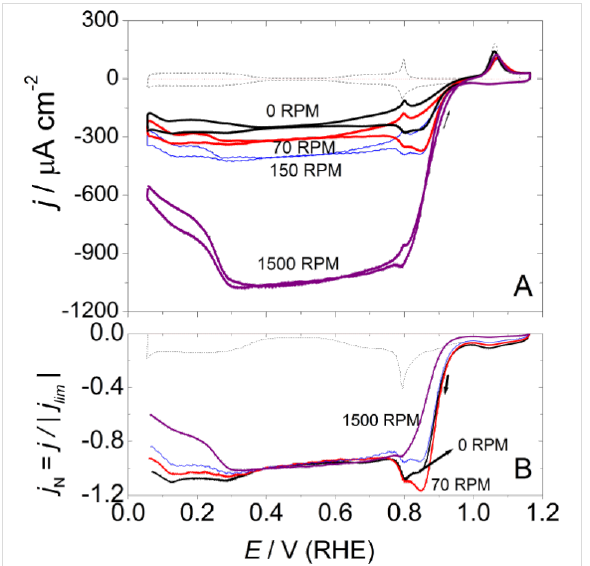
Figure 7: (A) Cyclic voltammograms for the ORR on a hanging meniscus rotating disc (HMRD) Pt(111) electrode from 0.06 to 1.15 V in 0.1 M HClO 4 , Ar/O 2 ratio 5:1. Scan rate 50 mV·s − 1 . (B) Nega- tively directed sweep normalized against the limiting currents from data in (A).